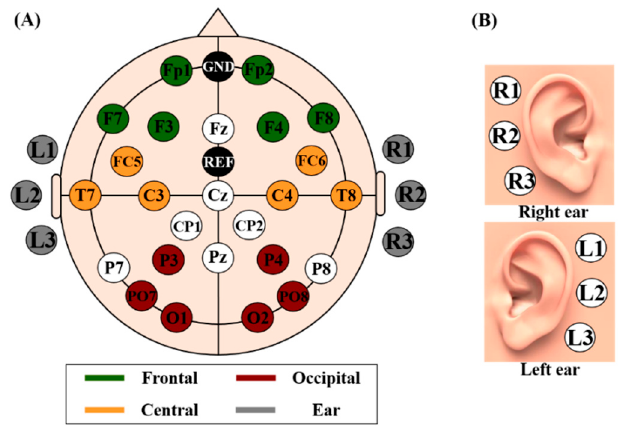
Figure 1. Electrode positions used to record EEG data. ( A ) The brain area is divided into four regions of interests (ROIs) for data analysis (frontal, central, occipital, and ear area). ( B ) The electrode placement for ear-EEG.